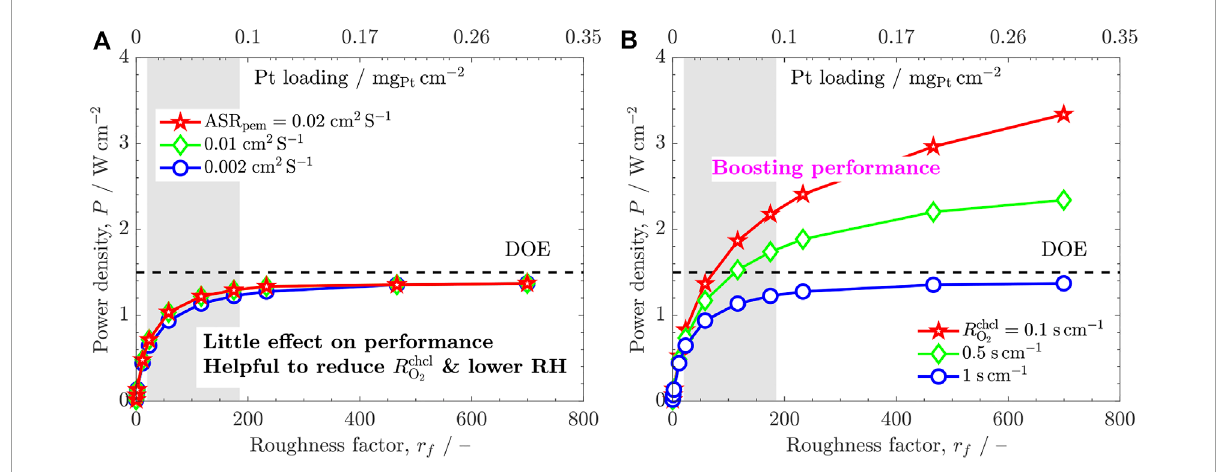
FIGURE 9 Variation of the geometric power density ( V cell = 0 . 5 V), P , with the roughness factor, r f , at the optimal design point, corresponding to: (A) three area-specific ohmic resistances, ASR pem = 0.02 (baseline case), 0.01, 0.002 cm 2 S −1 , and (B) three channel-CL oxygen transport resistances, R chcl O = 1 (baseline case),0.5,0.1 s cm −1 . See caption to Figure 8 for further 2